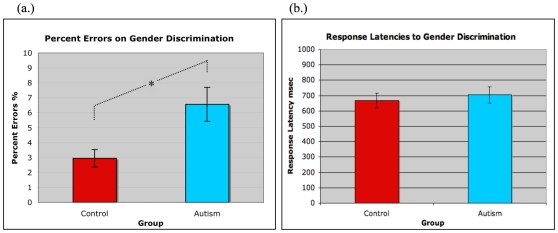
Performance data for gender discrimination of neutral mask faces.Performance by individuals with ASD (blue) and controls (red) was associated with mean group percent errors (a.) and response latencies (b.). The asterisk (*) indicates significant group differences.